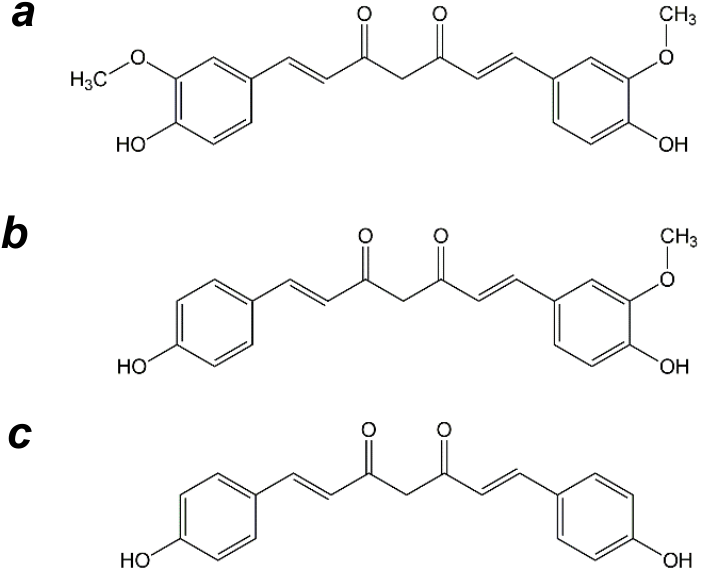
Figure 1. Curcuminoids structures ( a ) curcumin, ( b ) demethoxycurcumin and ( c ) bis-demethoxy- curcumin.